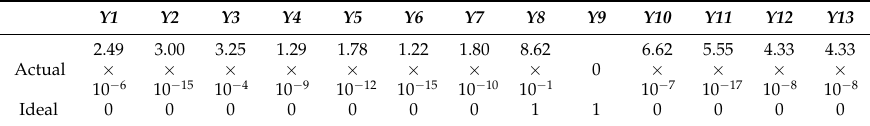
Table 6. The test results of a two symptoms ( X 2, X 18) to two faults ( Y 8, Y 9) relationship.